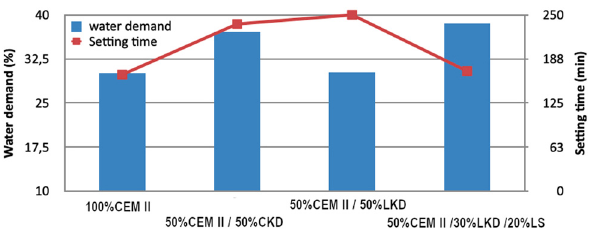
Figure 9: Water requirement and setting time for di ff erent combi - nations of binders: Cement ( CEM - II ) , CKD, LKD and LS.